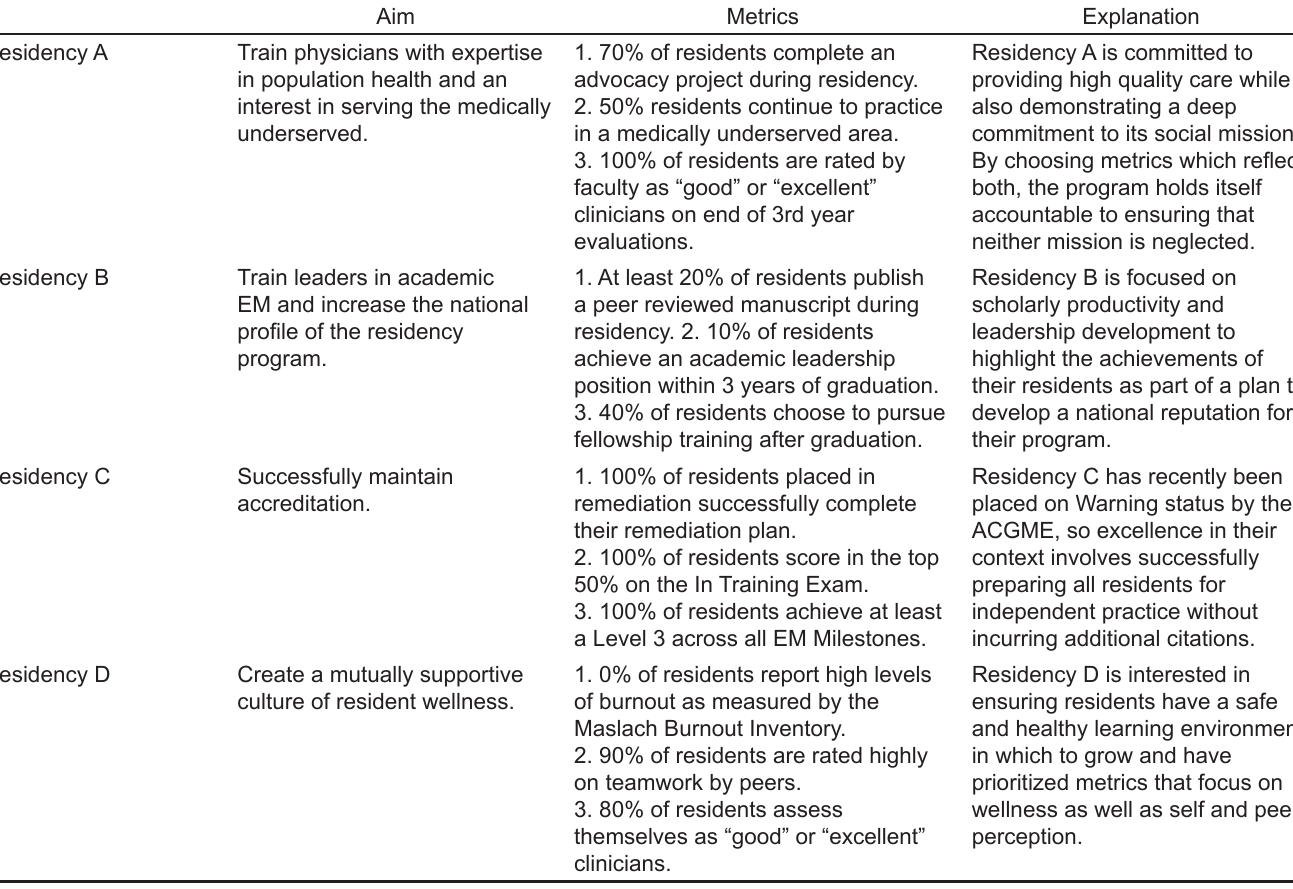
Table 2. Examples of incorporating metrics of resident achievement into the creation of program